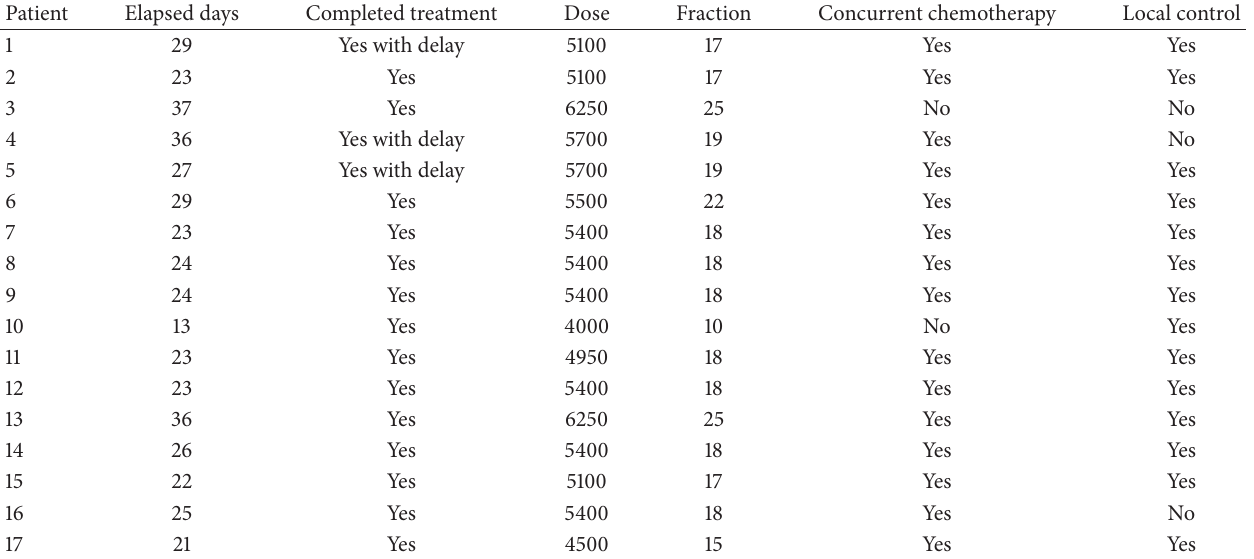
Table 3: Treatment characteristics.